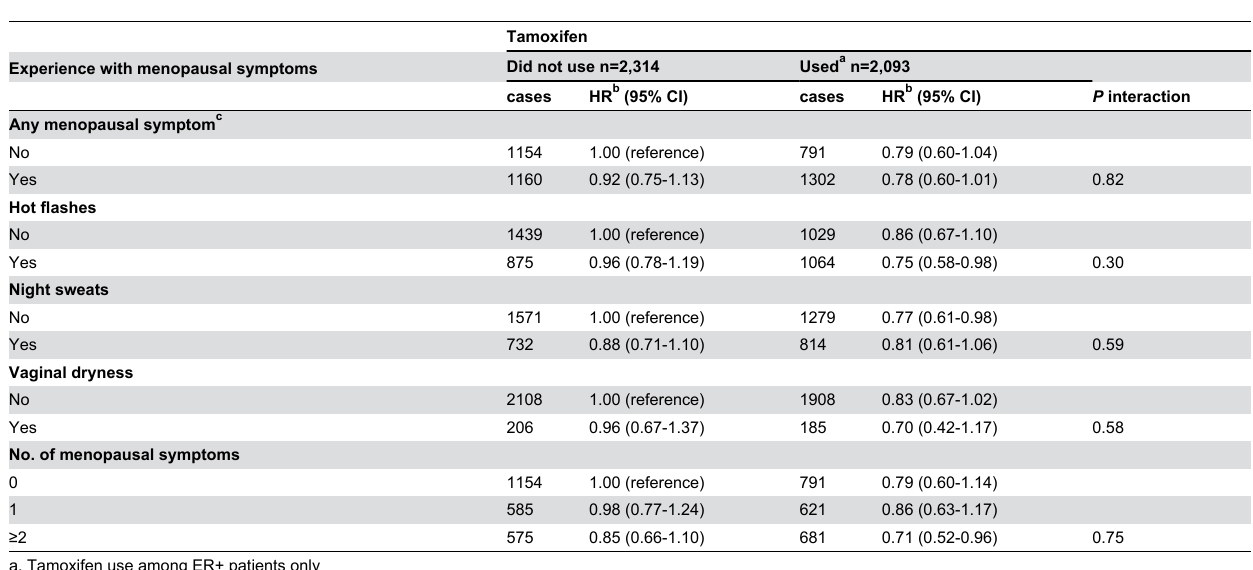
Table 5. Menopausal symptoms in association with breast cancer recurrence by tamoxifen use, SBCSS (n=4,842).